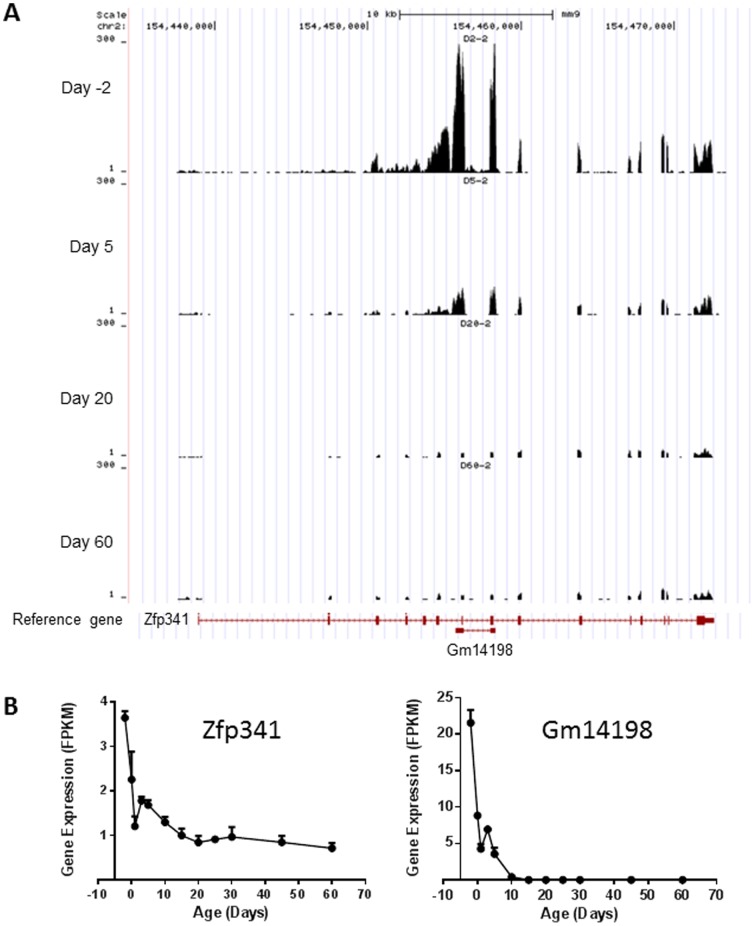
Developmental expression of antisense lncRNA Gm14198 (identified by Ensembl 66) and its neighbor protein coding gene Zfp341.(A) Sequence read distribution at day −2, 5, 20, and 60 viewed by the UCSC genome browser. (B) Gene expression (represented by FPKM) across the 12 selected ages.